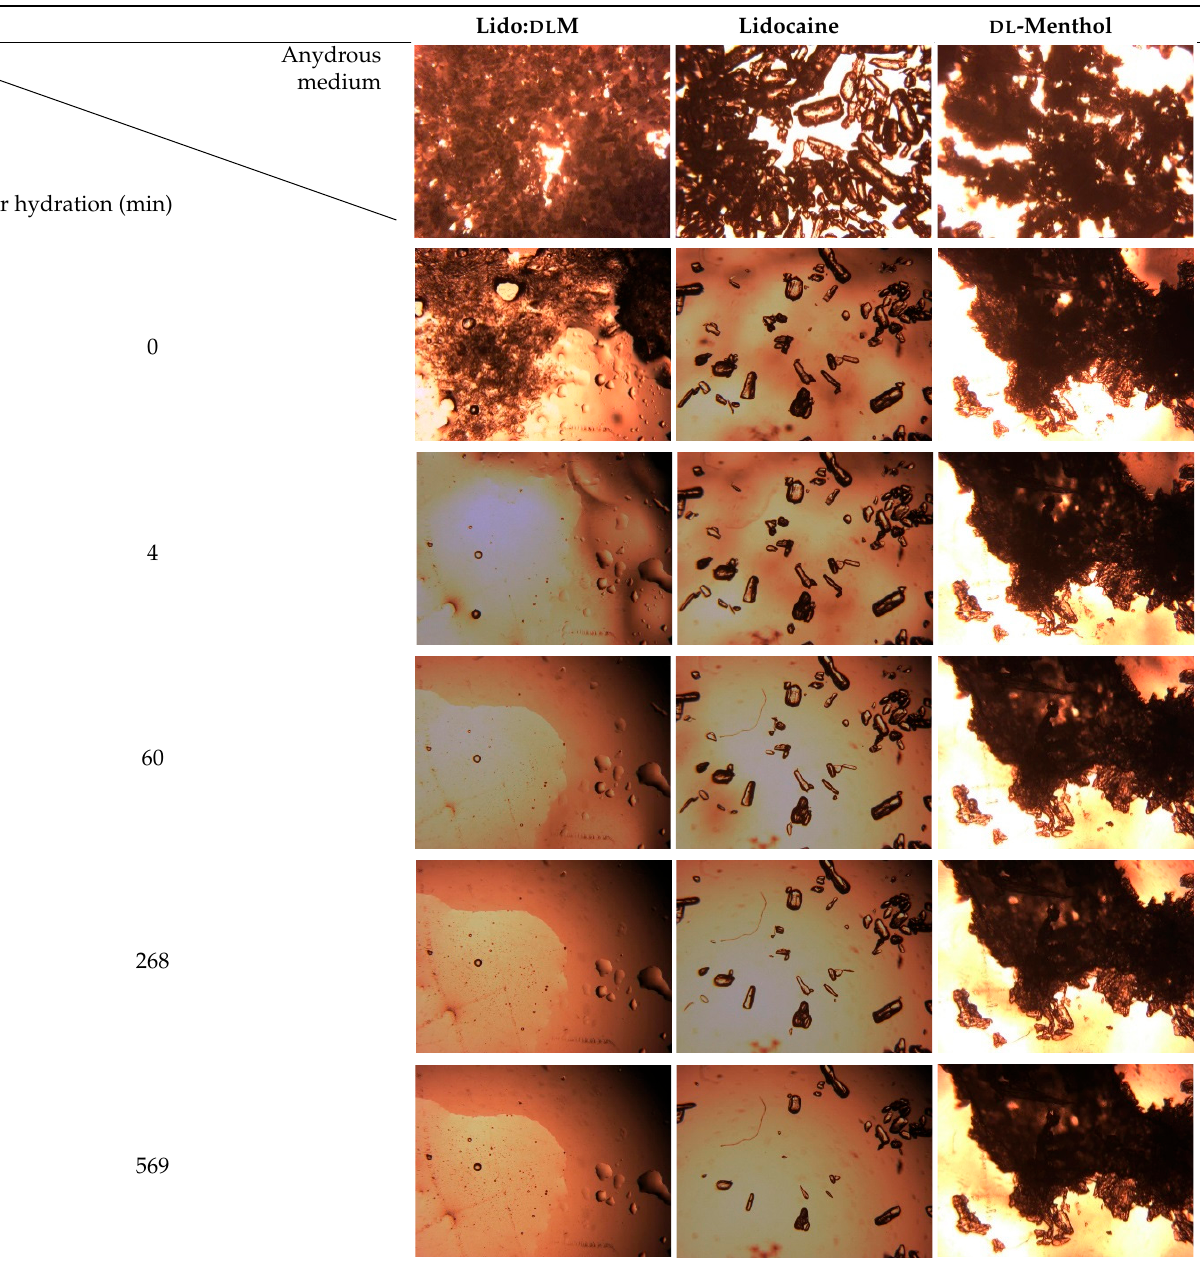
Table 7. Images illustrating the kinetics of dissolution of the lidocaine: DL -menthol cocrystal (17 mg · mL − 1 ) compared with pure constituents, i.e., lidocaine (10.2 mg · mL − 1 ) and DL -menthol (6.8 mg · mL − 1 ) at 25 ◦ C. Width of each image: 4 cm. Lido: DL M